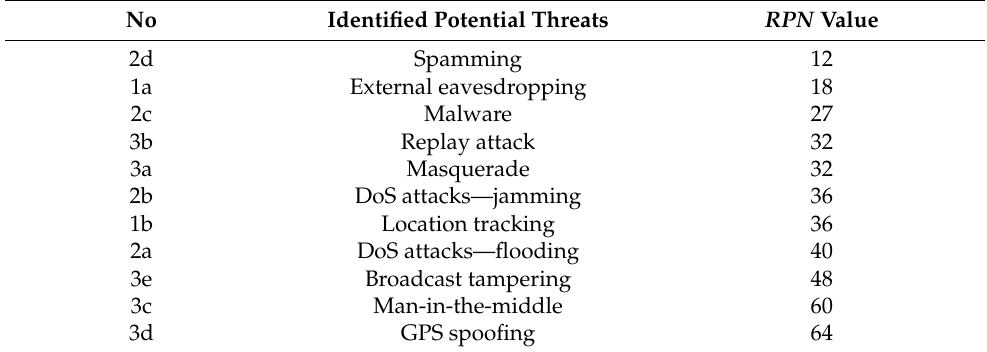
Table 4. Identified potential threats arranged according to their criticality (based on Table